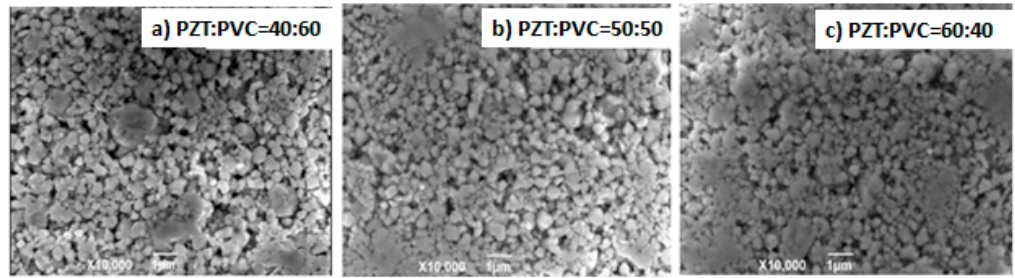
Figure 4. ( a ) The SEM images of the PZT/PVC (40:60); ( b ) The SEM images of the PZT/PVC (50:50); ( c ) The SEM images of the PZT/PVC (60:40).